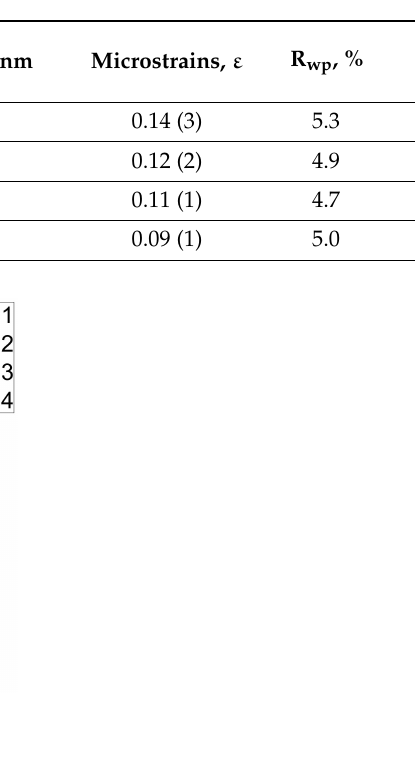
Table 2. Accurate parameters of structure and microstructure of tin oxide phase samples under study. Standard deviation in last sign pointed in brackets. The table shows data on the coherent scattering region (CSR size), microstrains ( ε ), R-factor (R wp ) and the χ 2 criterion.